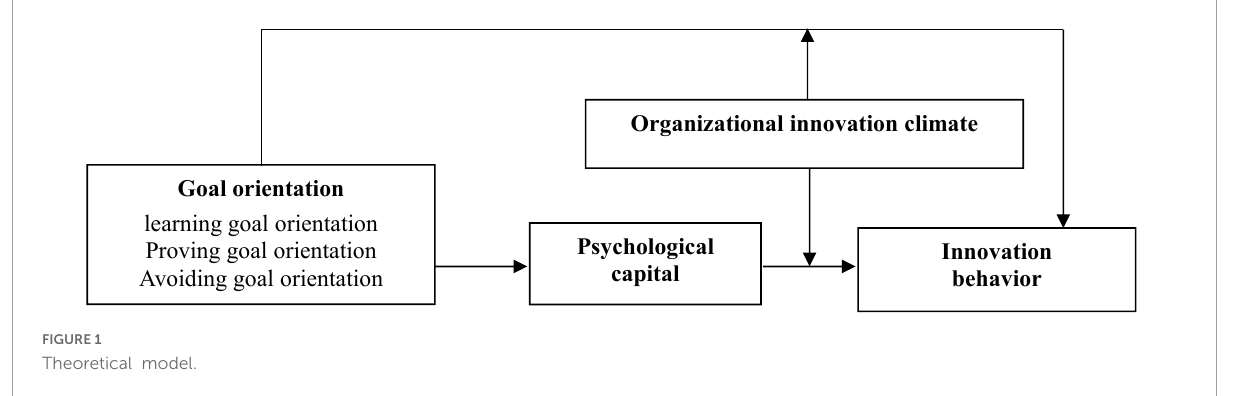
FIGURE1 Theoretical